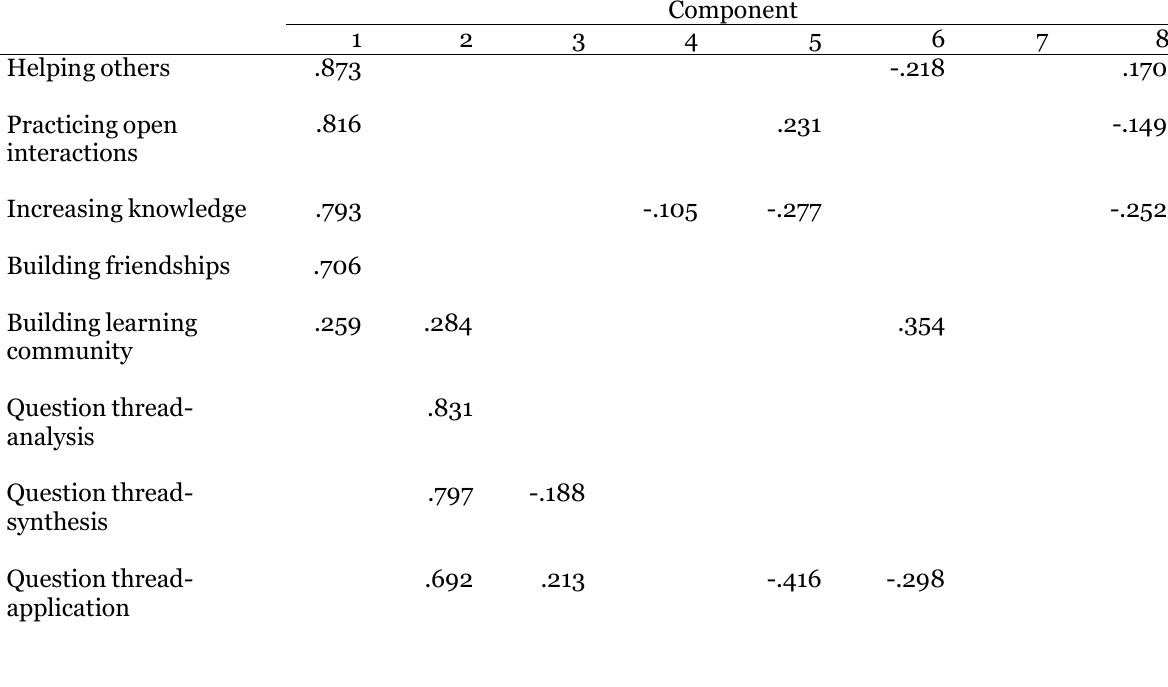
Factor Loadings Using Principal Component